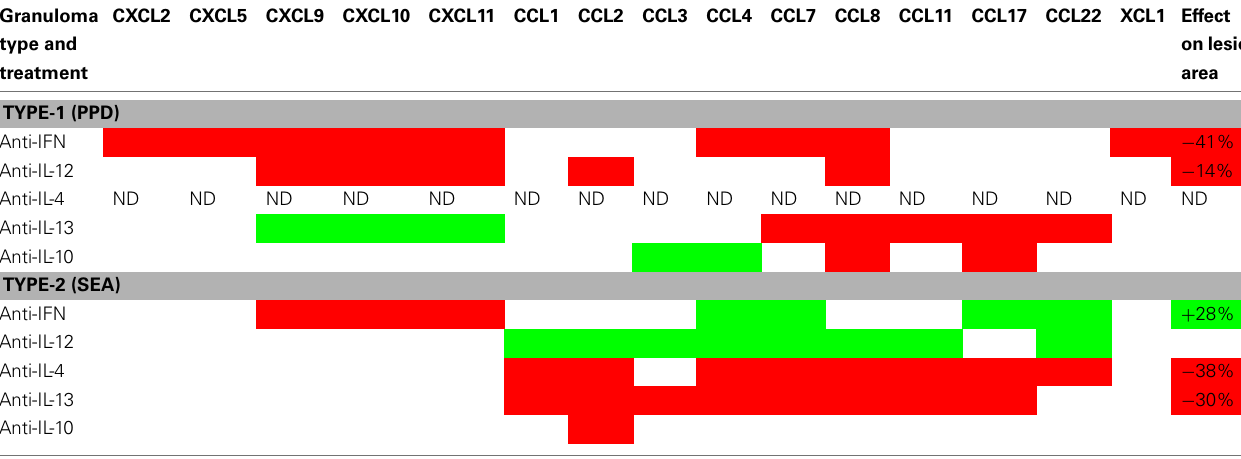
Table 1 | Effect of cytokine depletion of chemokine transcript expression and granuloma